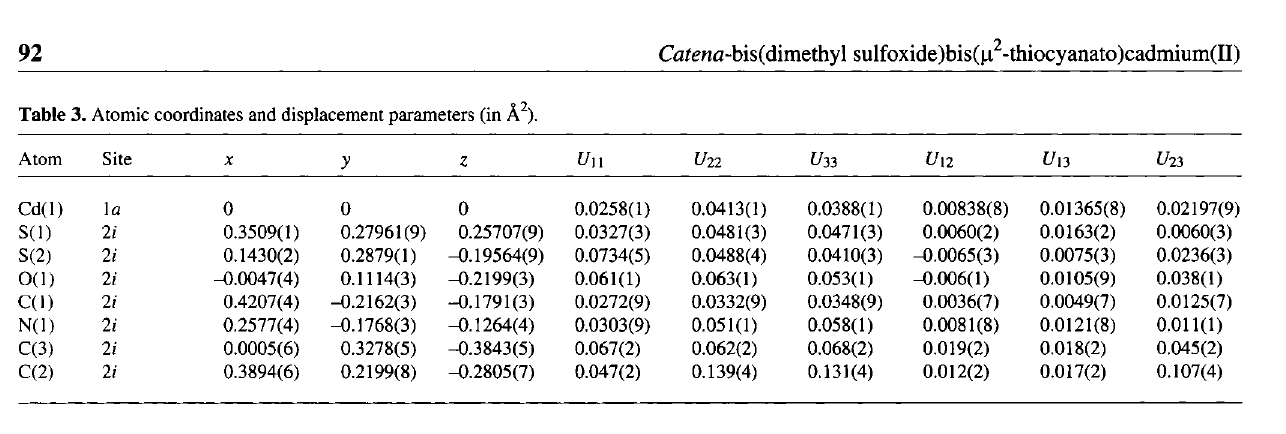
Table 3. Atomic coordinates and displacement parameters (in Ä 2